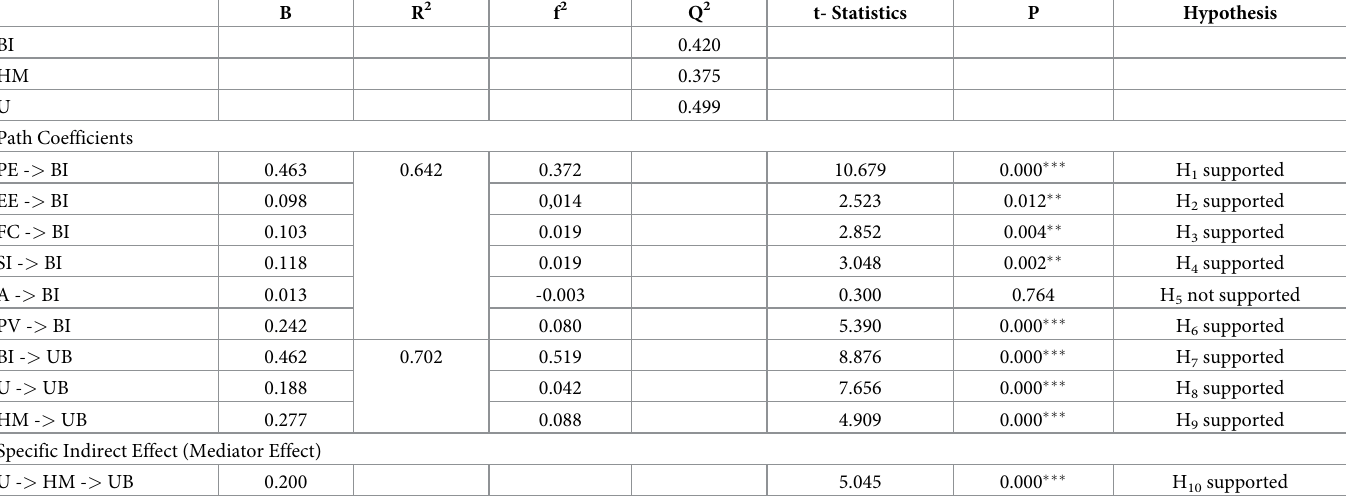
Table 3. The research model evaluation